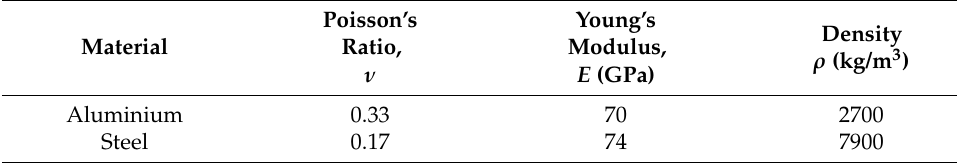
Table 1. The material properties.